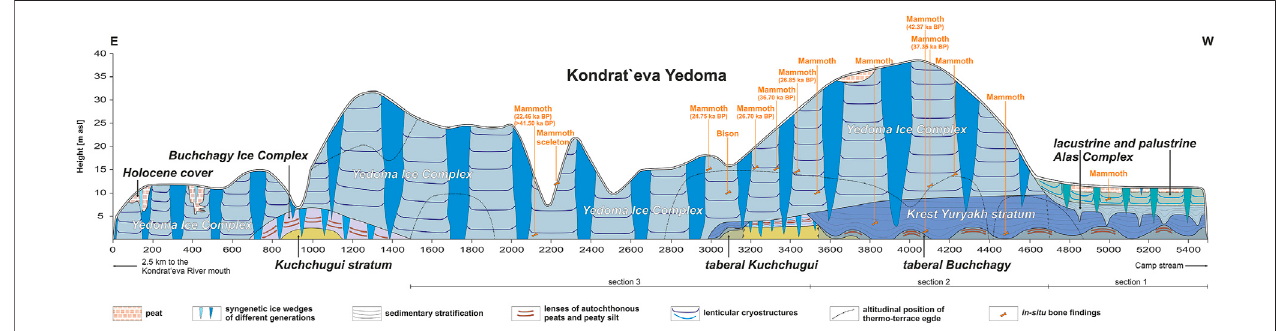
FIGURE 3 | Schematic structure of the Kondrat ’ eva Yedoma exposure on the Oyogos Yar coast from 2.5 to 8 km west of the Kondrat ’ eva River mouth [redrawn with changes from Tumskoy and Kuznetsova (2022).